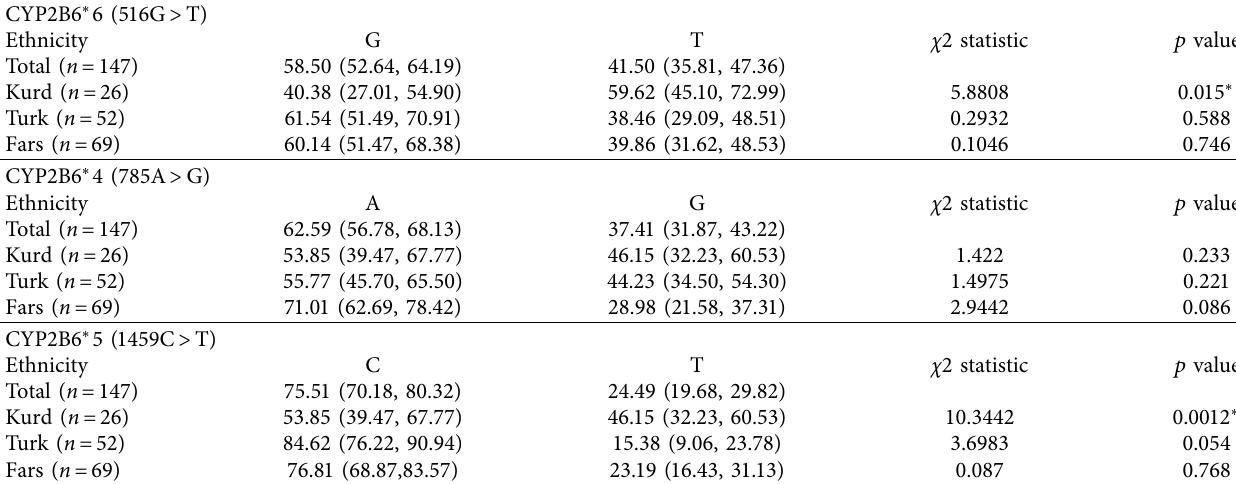
Table 3: Allele frequencies in Iranian